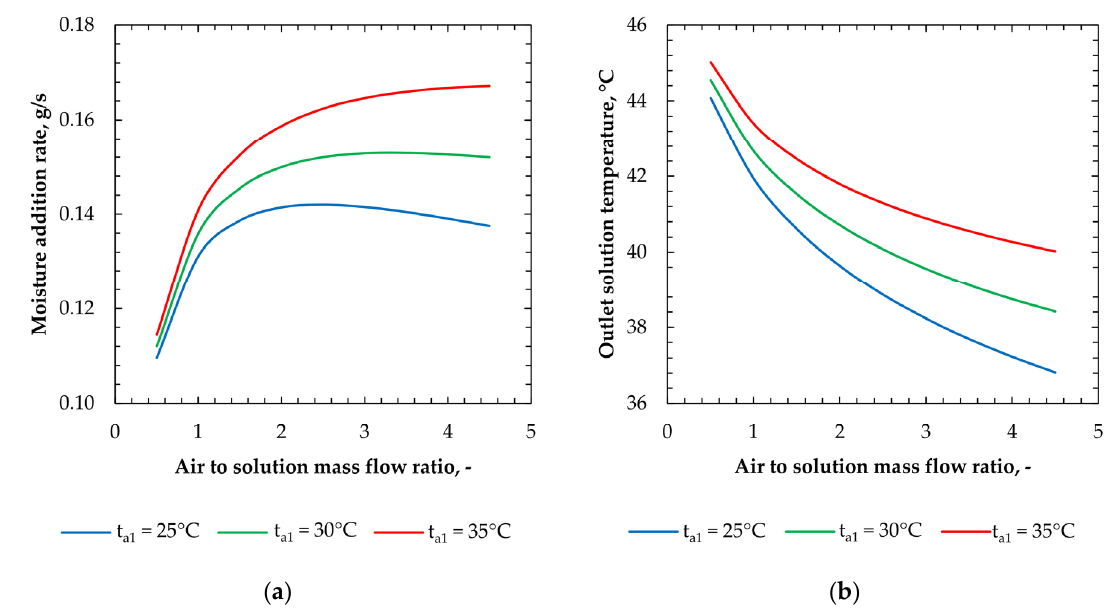
Figure 12. Effect of air to solution mass flow ratio in regard to different inlet air temperatures: ( a ) on moisture addition rate; ( b ) on outlet solution temperature.